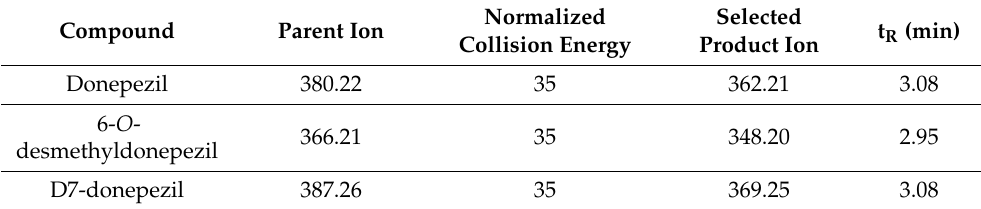
Table 5. LC–MS/MS setting